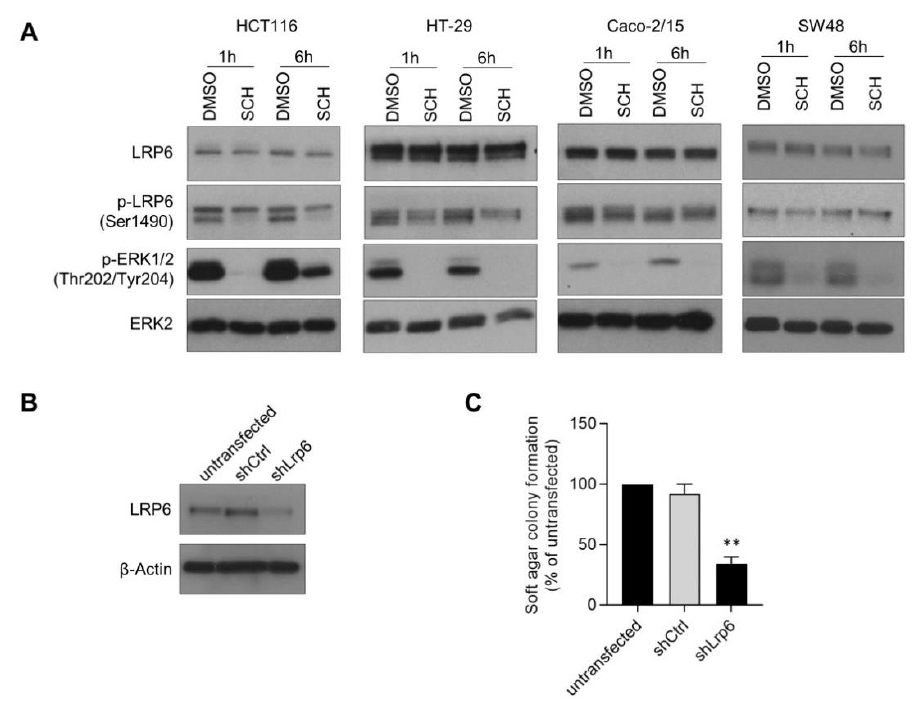
Figure 5. LRP6 phosphorylation contributes to BRAF-induced intestinal oncogenesis. ( A ) KRAS - mutated HCT116, BRAF -mutated HT-29, KRAS and BRAF wild-type Caco-2/15 and SW48 cells were treated with SCH772984 (1 µ M) or DMSO for 1 and 6 h. Protein expression and